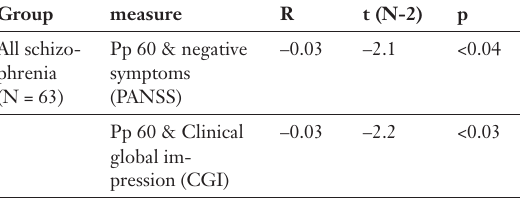
Statistical analyses – Spearman rank correlations. Comparison of schizo-